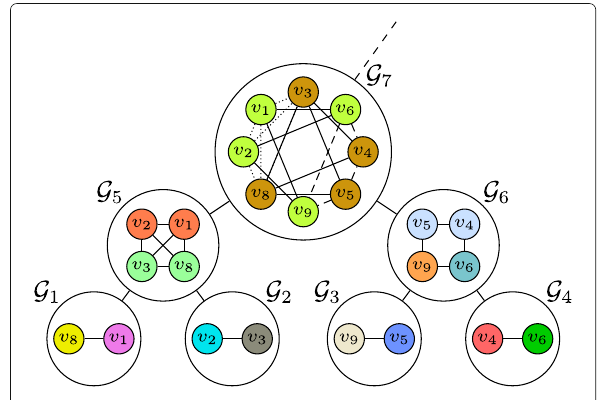
Fig. 15 k -ambiguity tree corresponding to the cliques shown in Fig. 14. Note that the tree nodes shown here do not correspond to the complete k -ambiguity tree; the root r of the tree is not